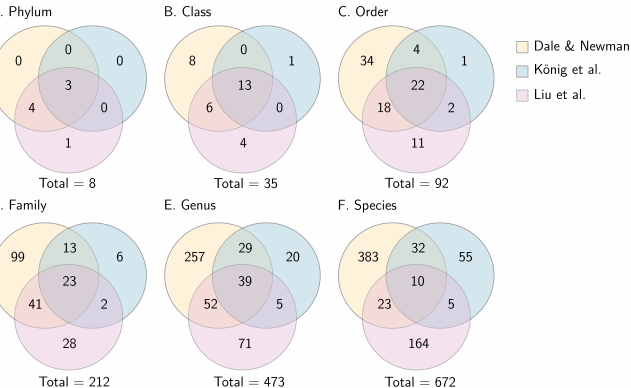
Figure 6. Comparison of the taxonomic diversity found in our study with that found in König et al. [27] and Liu et al. [28]. The Venn Diagrams show unique and shared numbers of phyla ( A ), classes ( B ), orders ( C ), families ( D ), genera ( E ) and species ( F ). It is clear that the overlap in diversity between the three studies is low. In (F), the 10 species that are common to all three studies are: Alternaria rosae , Cystofilobasidium macerans , Filobasidium magnum , Zymoseptoria verkleyi , Sporobolomyces roseus , Dioszegia hungarica , Buckleyzyma aurantiaca , Rhodotorula babjevae , Malassezia restricta , Blumeria graminis